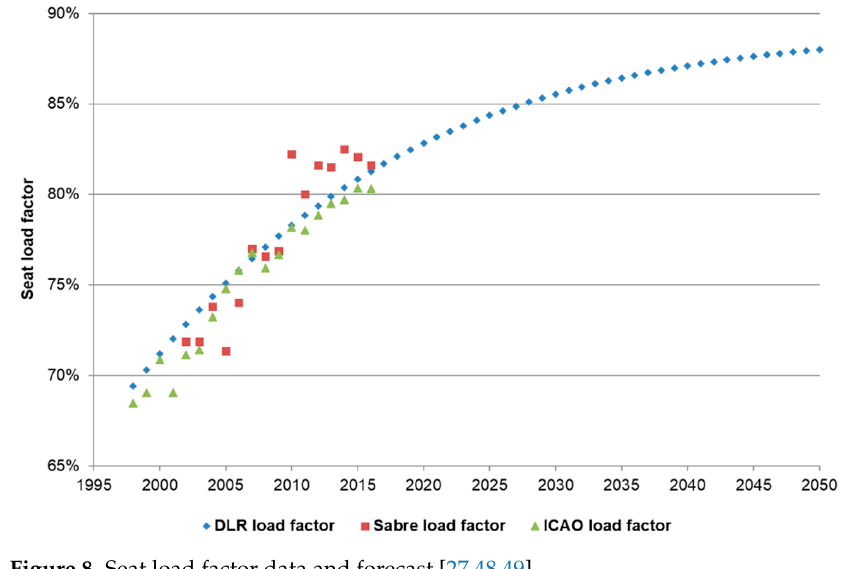
Figure 8. Seat load factor data and forecast [27,48,49].